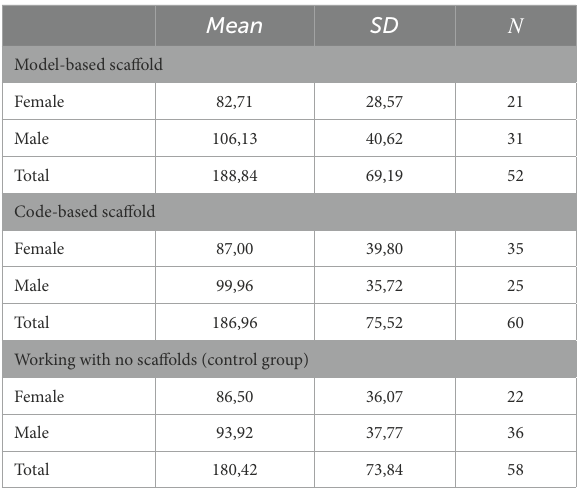
TABLE 8 Descriptive statistics of children’s computational thinking in Phase 3 for each scaffold and gender.